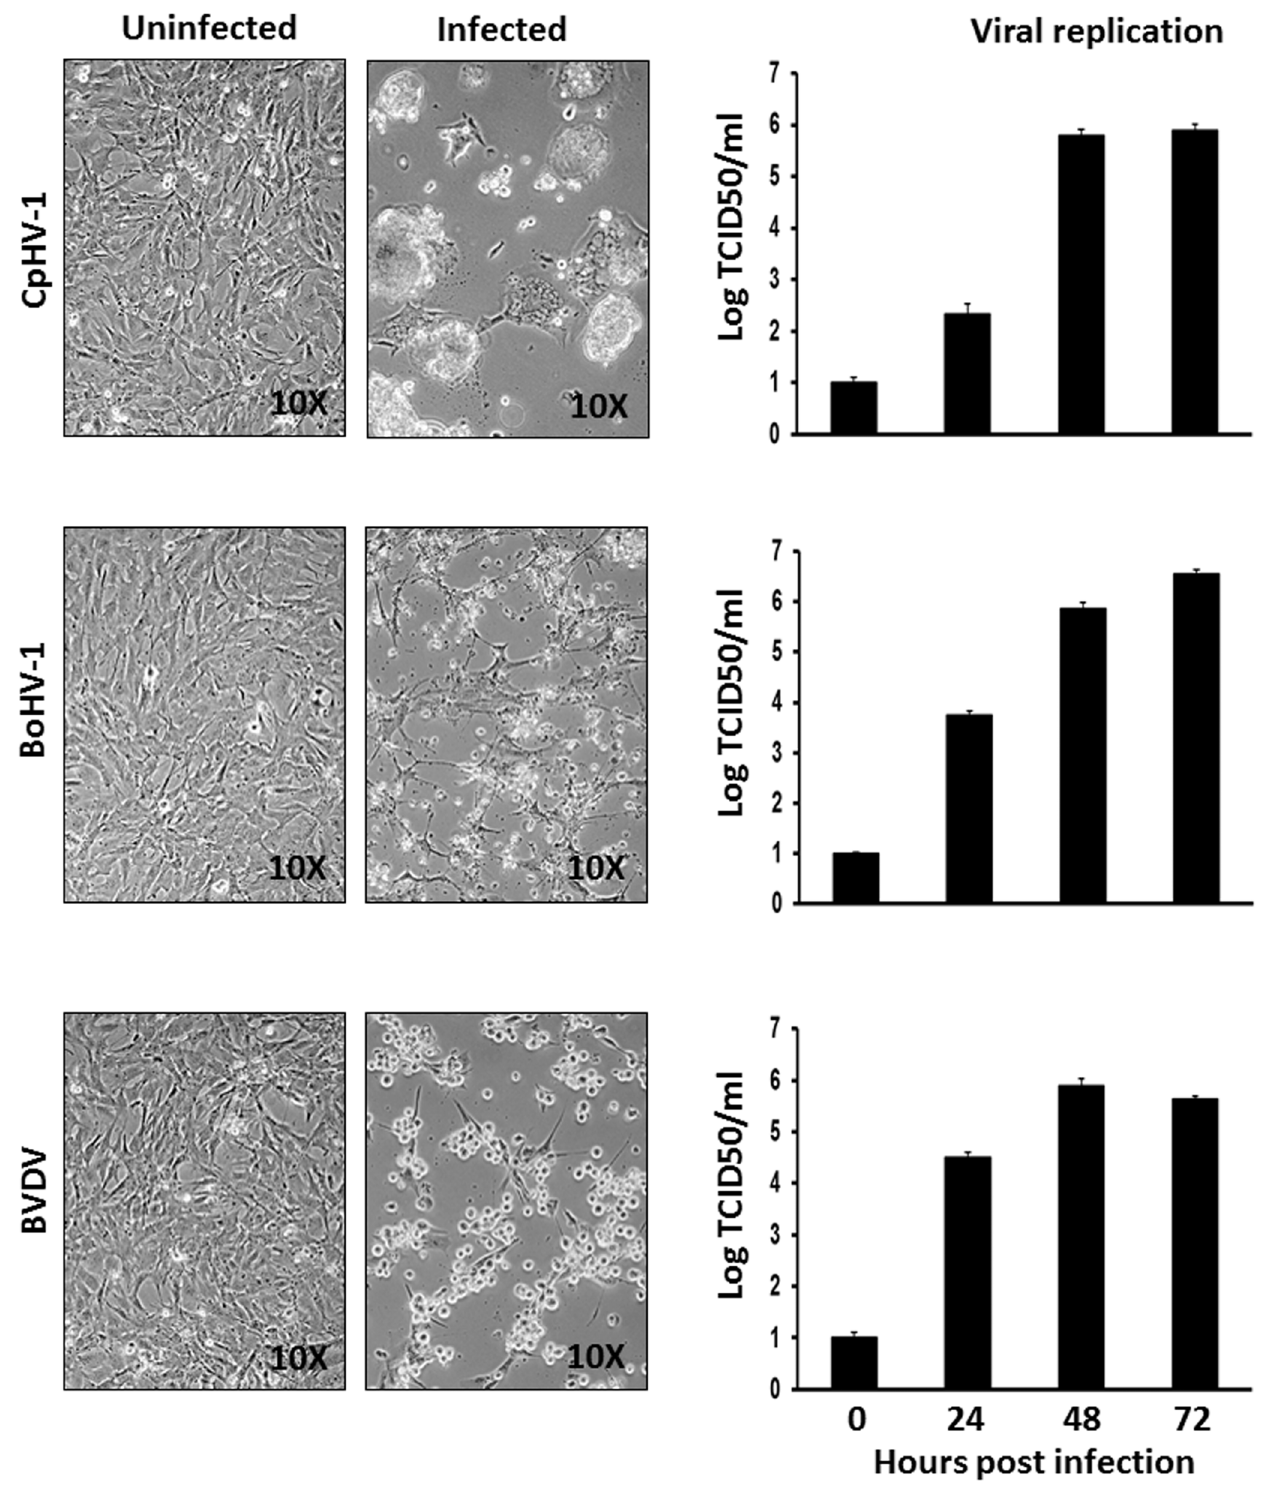
Figure 3. ASSC viral infection. Representative phase contrast images (10x) of uninfected and infected (CpHV-1, BoHV-1 and BVDV) ASSCs 48 h post infection, along with the replication kinetics of the respective viruses expressed as log TCID 50 /ml. The data presented are the means 6 standard errors of triplicate measurements ( P . 0.05 for all time points as measured by Student’s t test). doi:10.1371/journal.pone.0105643.g003 Virus isolation from clinical specimens is one of the main goals cultures, in chicken embryos and, to a lesser extent, in laboratory in diagnostic laboratories and it is generally carried out in cell animals [30]. Primary cultures, derived from animal tissues that